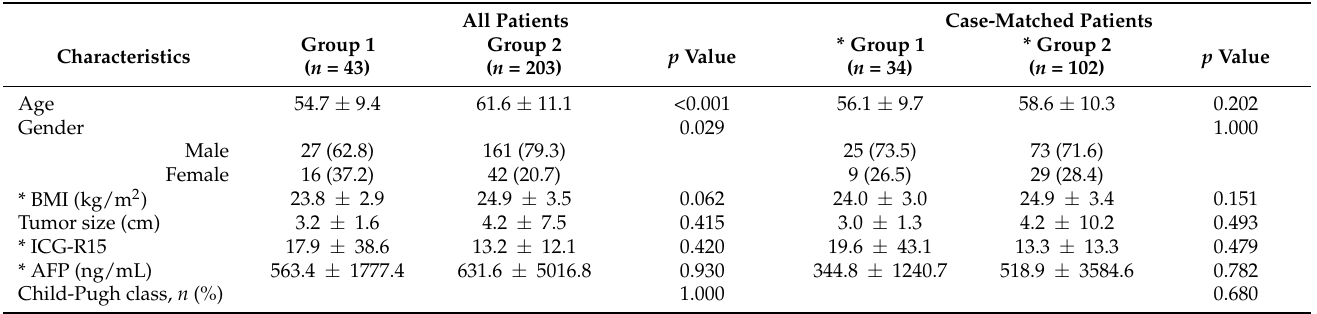
Table 1. Preoperative characteristics of laparoscopic liver resection for hepatocellular carcinoma in posterosuperior segments of the